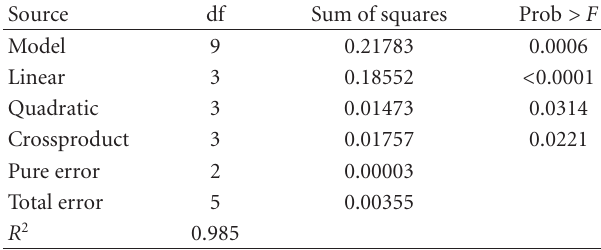
Table 2: Analysis of variance for synthesis variables pertaining to the response of percent molar conversion.